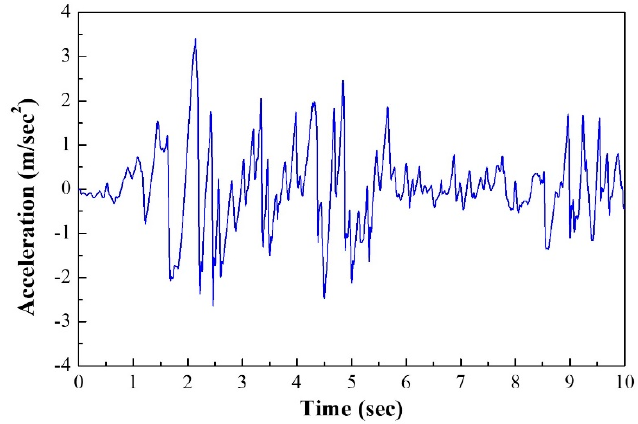
Figure 3. El Centro earthquake for training.